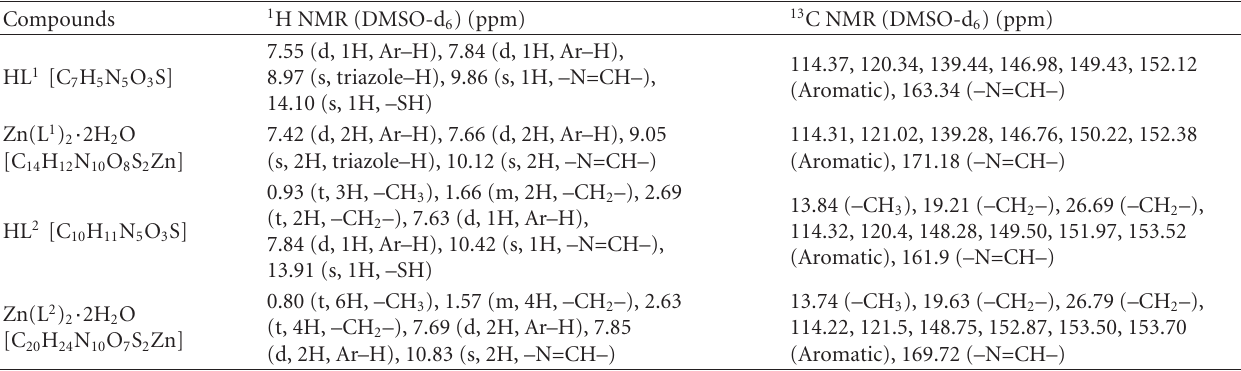
Table 1: 1 H NMR and 13 C NMR spectral data of Schi ff bases and their metal complexes.